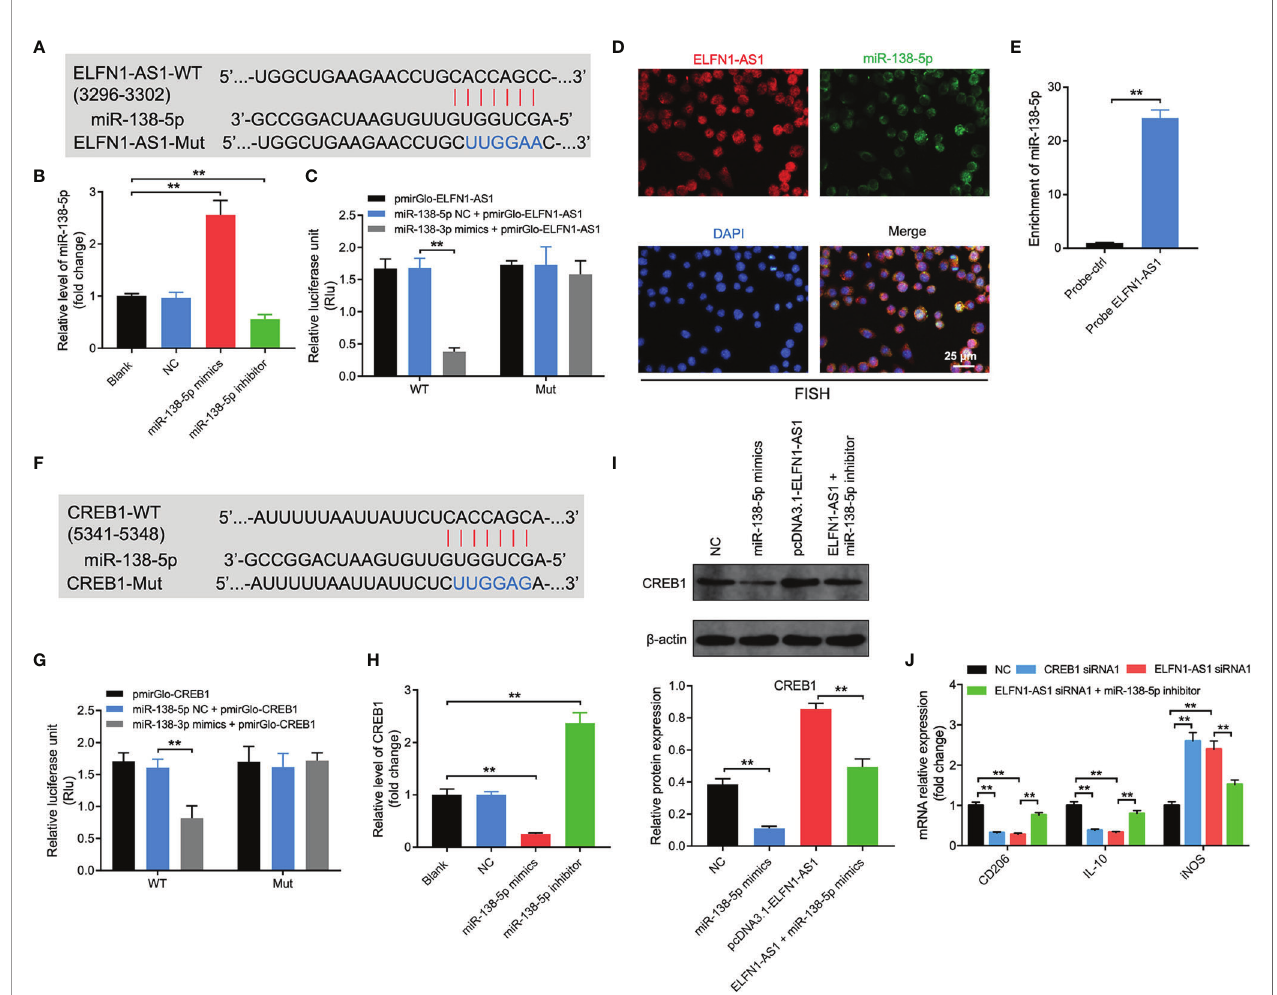
FIGURE 6 | Exosomal ELFN1-AS1 promoted macrophage M2 polarization via regulation of miR-138-5p/CREB1 axis. (A) Schematic diagram of binding sites between ELFN1-AS1 and miR-138-5p. (B) RT-qPCR analysis of miR-138-5p level in macrophages after transfecting with miR-138-5p mimics or miR-138-5p inhibitor (n = 3). (C) Luciferase activity in macrophages treated with the ELFN1-AS1-wt/mut plasmids together with miR-138-5p mimics was analyzed (n = 3). (D) FISH detection of ELFN1-AS1 and miR-138-5p in macrophages. (E) RNA pull-down assays were used to determine the interaction between ELFN1-AS1 and miR-138-5p (n = 3). (F) Schematic diagram of binding sites between CREB1 and miR-138-5p. (G) Luciferase activity in macrophages treated with the CREB1-wt/mut plasmids together with miR-138-5p mimics was analyzed (n = 3). (H) RT-qPCR analysis of CREB1 level in transfected macrophages. (I) Western blot analysis of CREB1 expression in transfected macrophages (n = 3). (J) RT-qPCR analysis of CD206, IL-10, iNOS level in transfected macrophages (n = 3). The signi fi cance between two or more groups was analyzed by Student ’ s t test or one-way ANOVA respectively. **P <